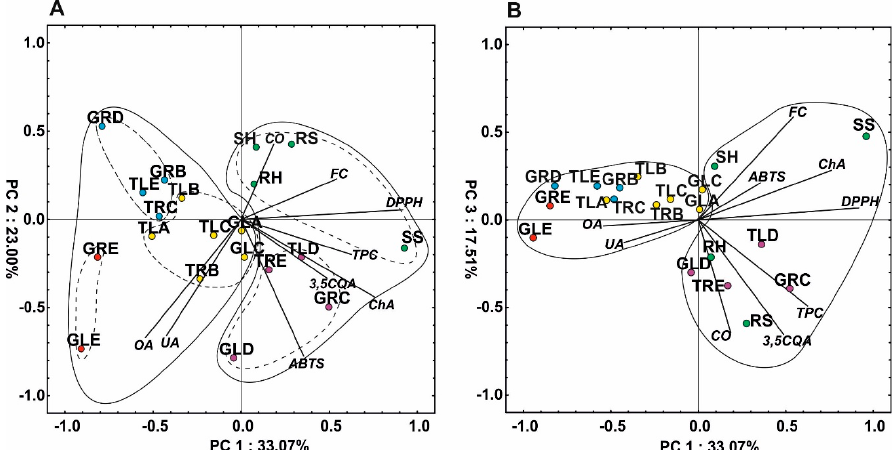
Figure 4. Scatter plot of the PCA of the antioxidant capacity and metabolites determined in the plant material; ( A ) PC1 versus PC2, ( B ) PC1 versus PC3. Different colors describe groups of